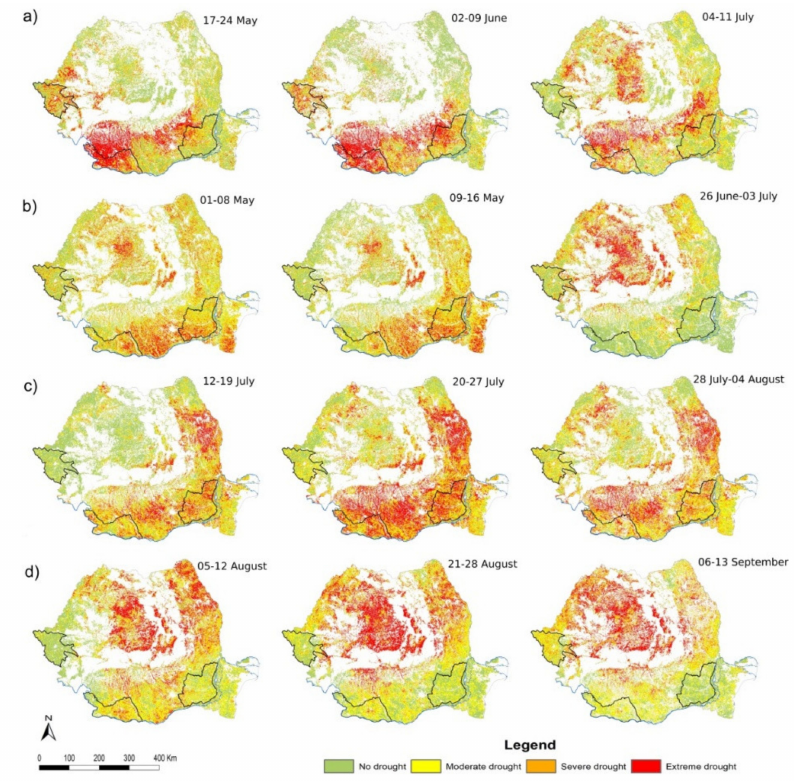
Figure 3. Drought Severity Index in the agricultural areas of Romania in: ( a ) 2002; ( b ) 2003; ( c ) 2007; ( d ) 2012.